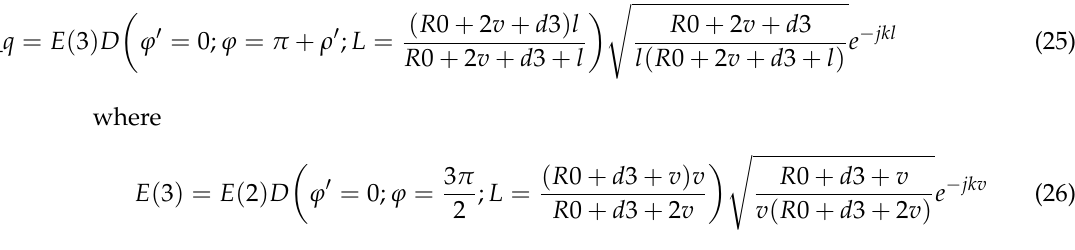
Figure 16. Quadruple diffraction (Edif_q) of the first considered NLOS scenario.